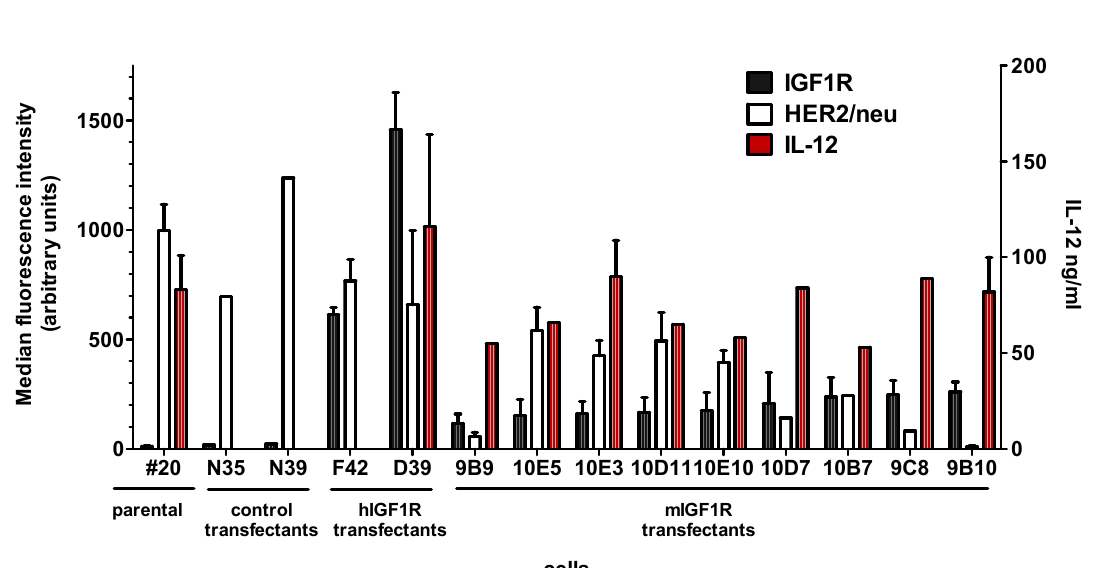
Figure 2. Membrane expression of rat HER2 / neu and IGF1R and production of IL12 in #20 cells, in two neomycin-resistant control transfectants, in two hIGF1R-, and in nine mIGF1R-top expressing clones. Mean fluorescence intensity in arbitrary units is reported in the left Y-axis for membrane expression of IGF1R and HER2 / neu. Production of IL12 (ng / mL of supernatant) is reported in the right Y-scale. Mean and standard error is shown.